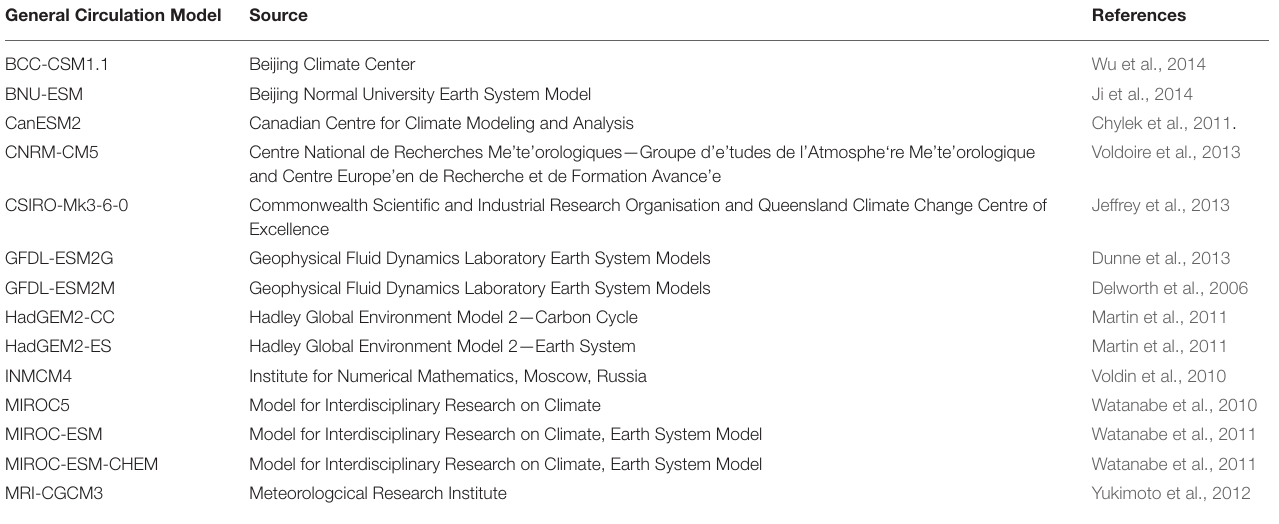
General Circulation